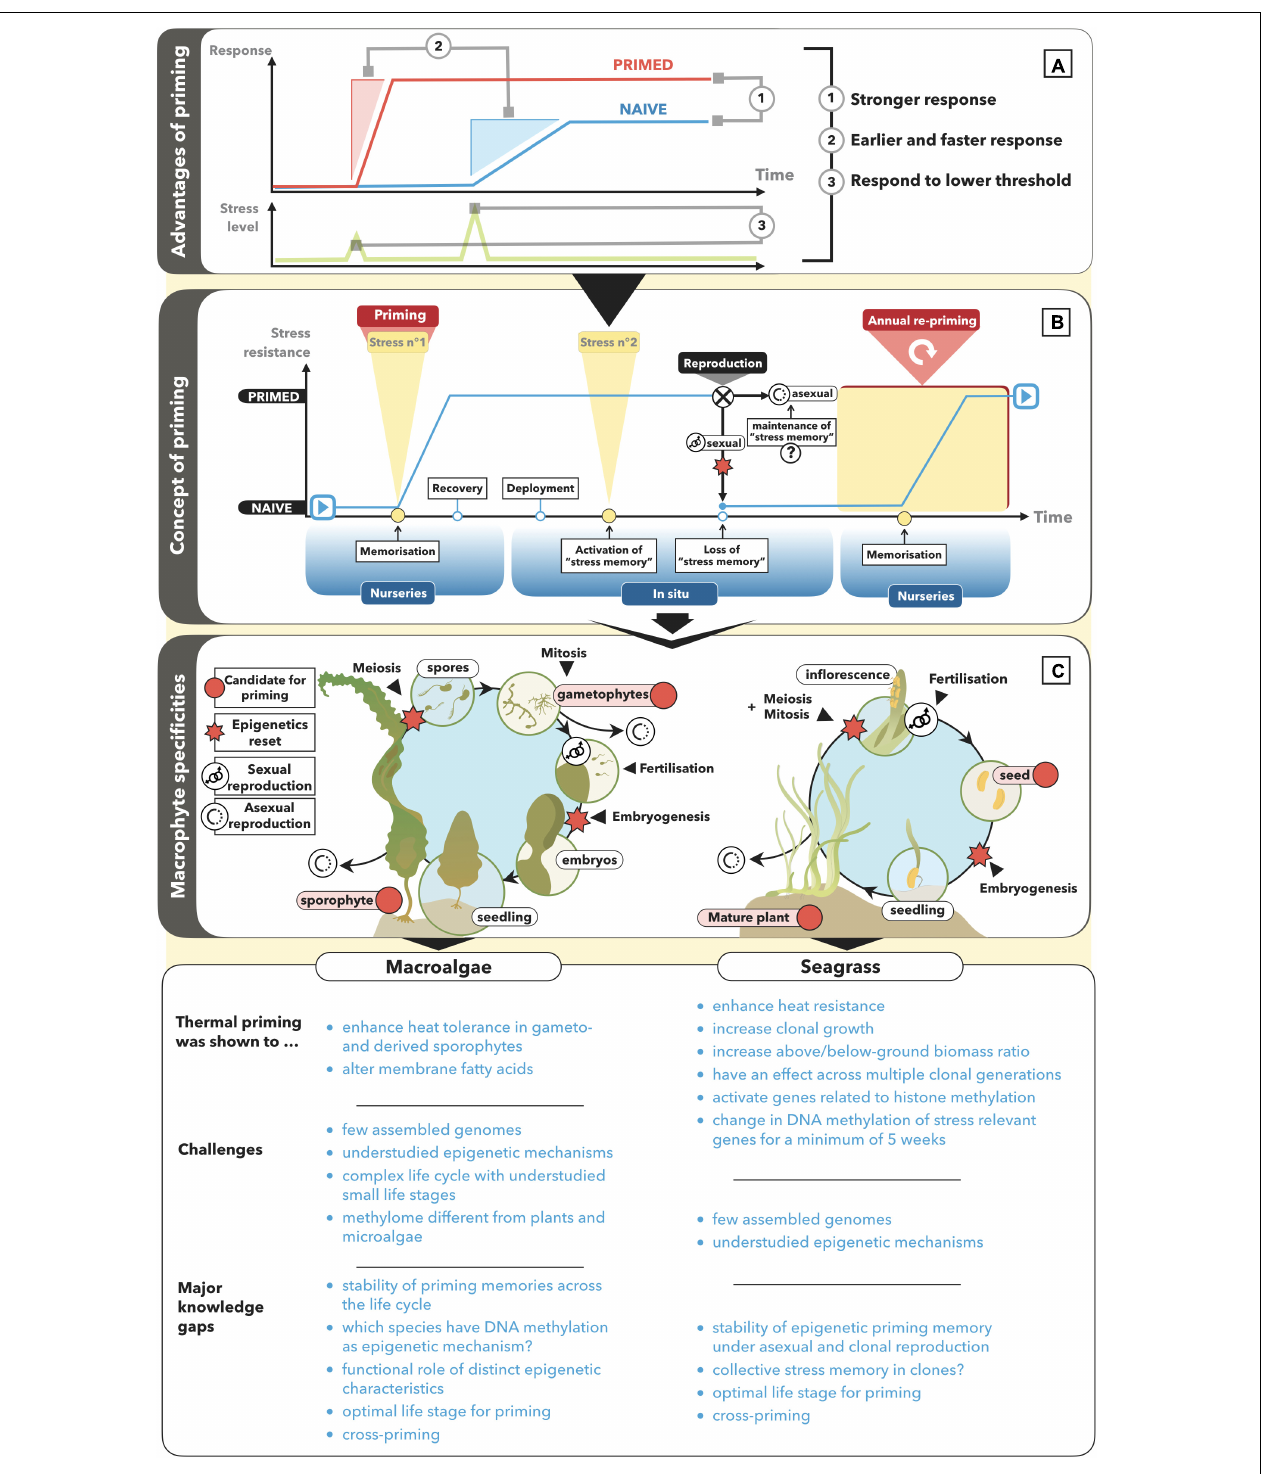
FIGURE 1 | Concept of priming and potential for its application in macroalgae and seagrass. (A) A primed organism responds faster, earlier, stronger or to a lower threshold of a stressful triggering stimulus as compared with a naïve organism. (B) A naïve organism is primed by building up a memory of a certain stress stimulus. The stress memory is more likely to be heritable across asexually produced generations than across sexually produced generations because of epigenetic reprogramming under gametogenesis (meiosis) and embryogenesis. (C) At which stage priming is best applied depends on the stability/transfer of a priming memory across the life cycle stages of kelp and seagrass. The state of the art, challenges and knowledge gaps to establish priming as a novel bio-engineering technique in marine macrophytes are listed for macroalgae and seagrass, respectively.